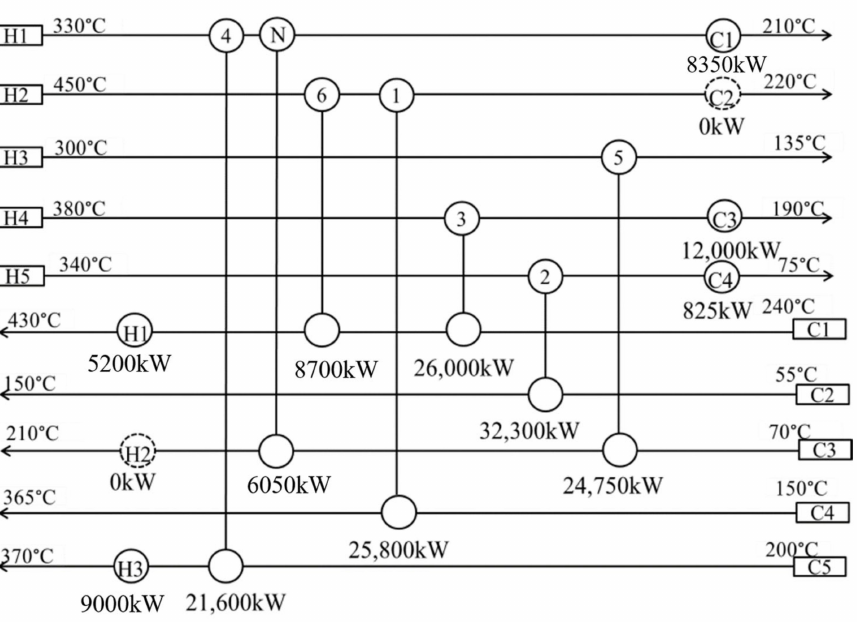
Figure 22. The first-step modification for retrofit HEN by adding a new shell and tube heat